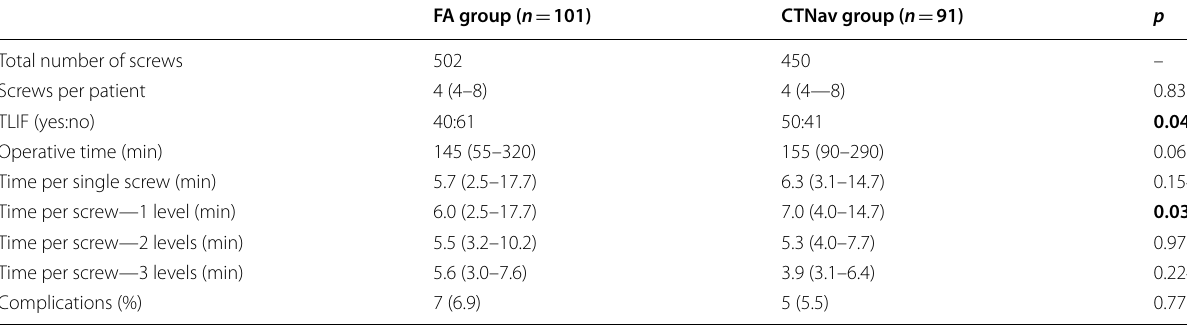
101) and CTNav group ( n =